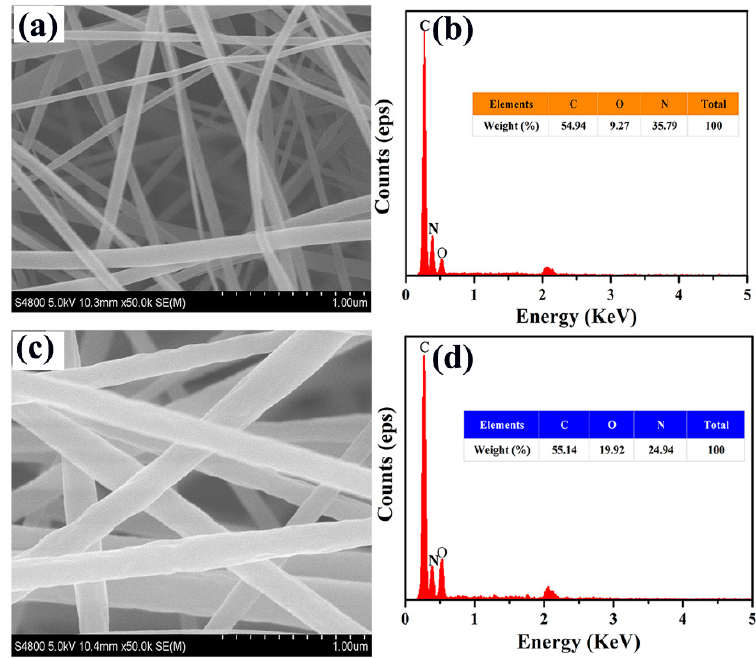
Figure 2. ( a , b ) SEM images of PAN and PAN–TA-3 nanofibers; ( b , d ) EDX spectra of PAN and PAN–TA-3 nanofibers before cross-linking by glutaraldehyde.